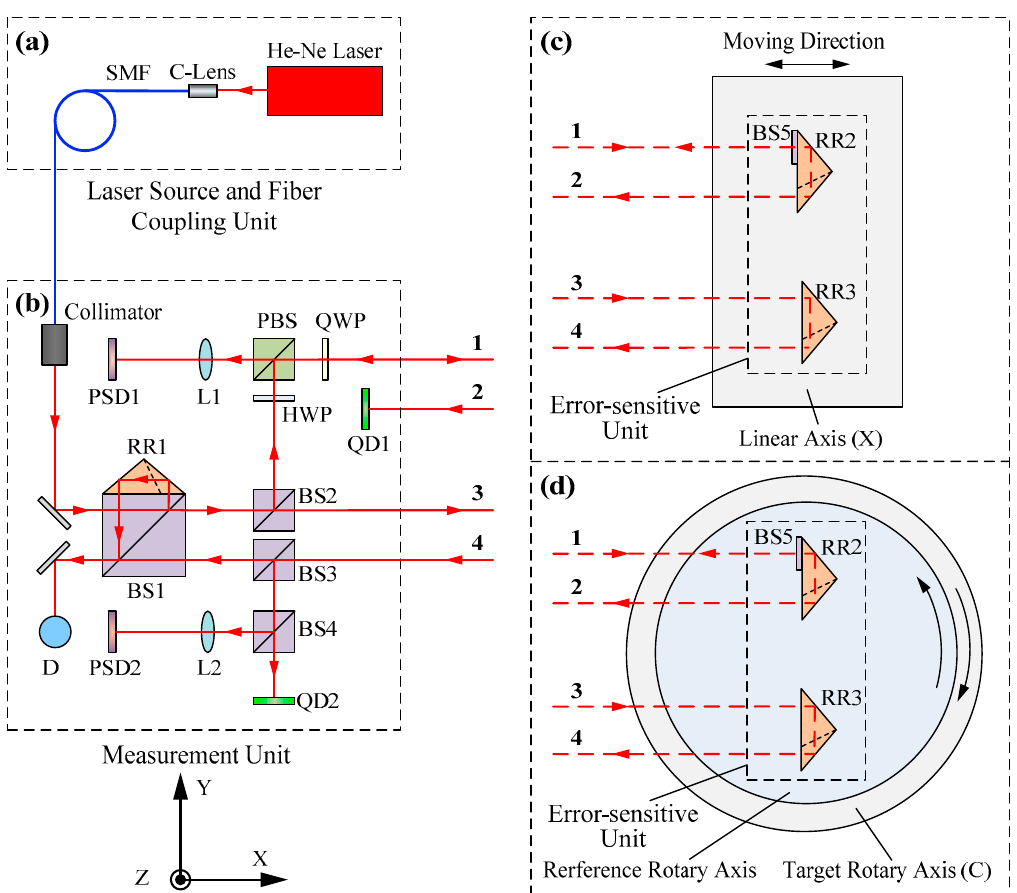
Figure 2. Schematic diagram for simultaneously measuring 6DOF geometric motion errors of both linear and rotary axes; ( a ) Laser source and fiber coupling unit; ( b ) Measurement unit; ( c ) Error-sensitive unit for measuring a linear axis; ( d ) Error-sensitive unit for measuring a rotary axis.